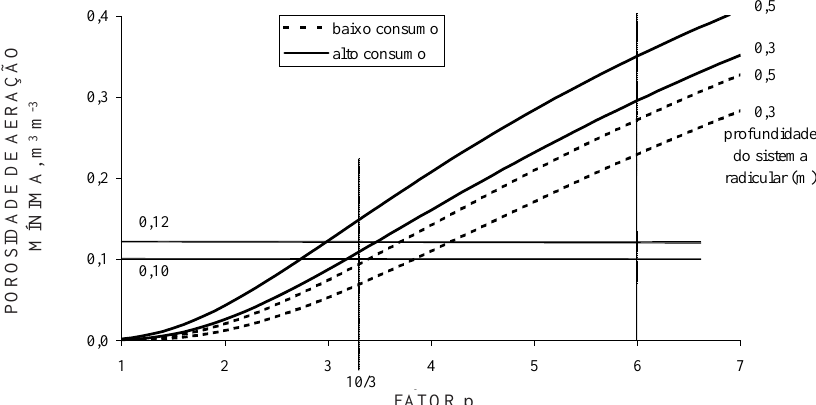
Figura 2. Porosidade de aeração mínima em função do valor do fator p da equação 11, para duas profundidades de aeração e nível baixo (6,1.10 -8 kg m -3 s -1 ) e alto (28,3.10 -8 kg m -3 s -1 ) de consumo de oxigênio.